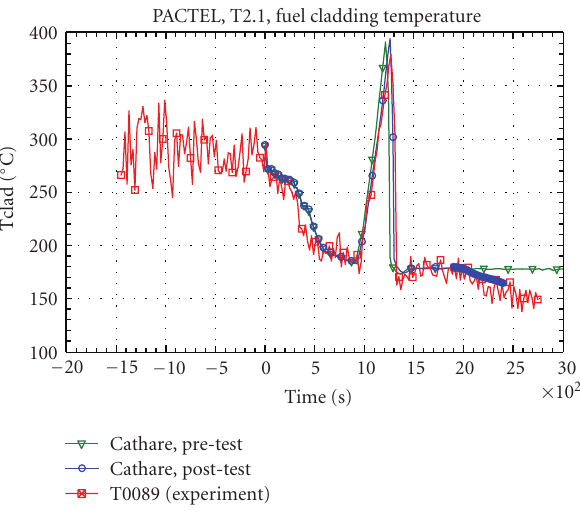
Figure 9: Fuel cladding